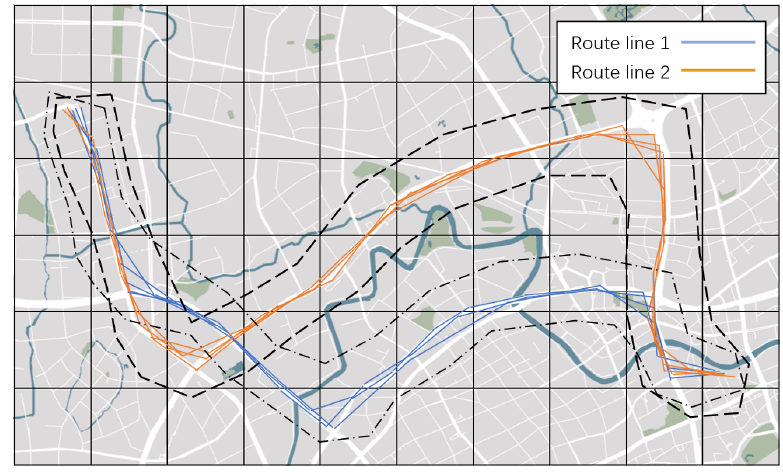
Figure 7. Historical roadmap (clustered).